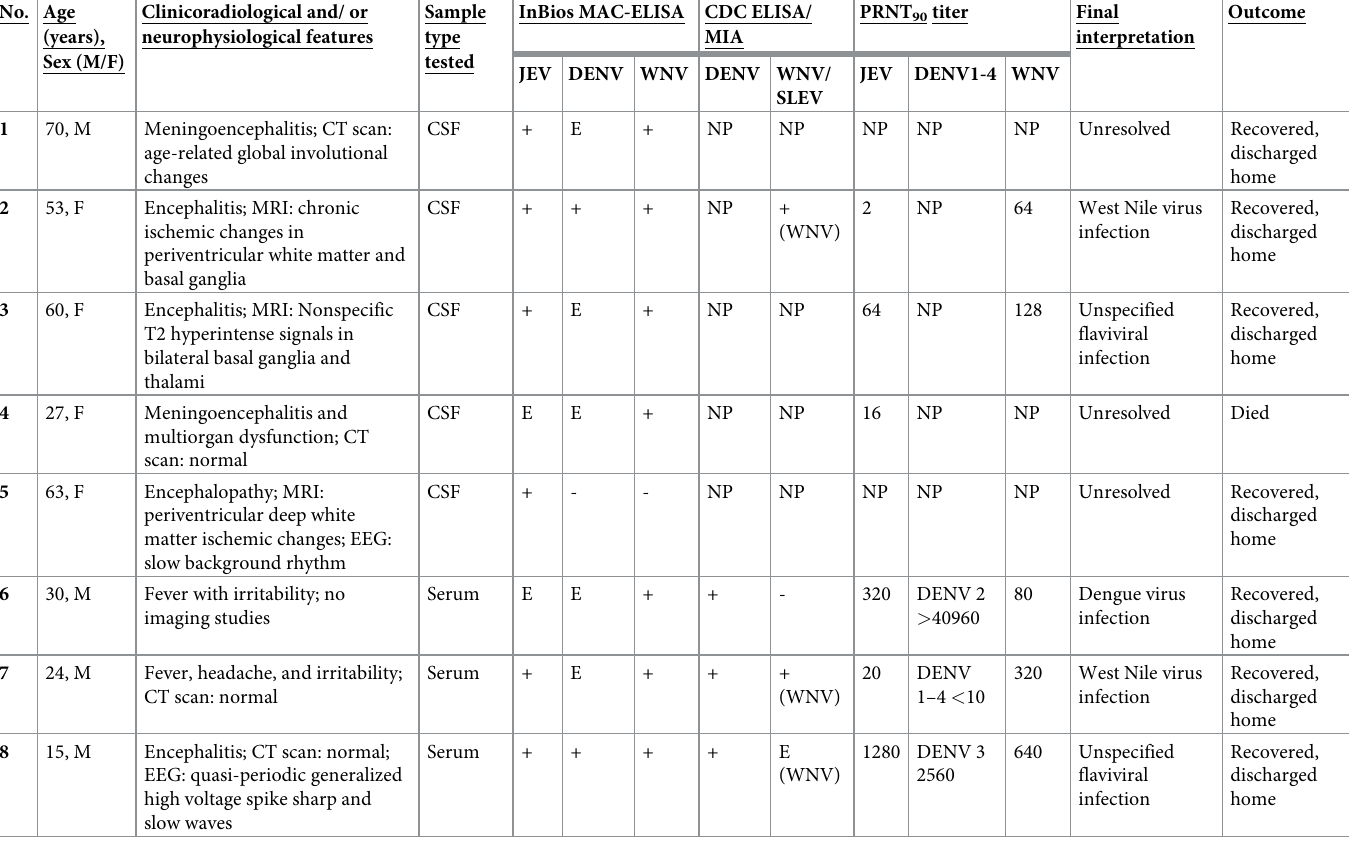
Table 1. Characteristics, clinicoradiological features, and flaviviral IgM and PRNT results in CSF and serum samples of eight patients positive for JE IgM on initial testing. No. Age Clinicoradiological and/ or (years), Sex (M/F)